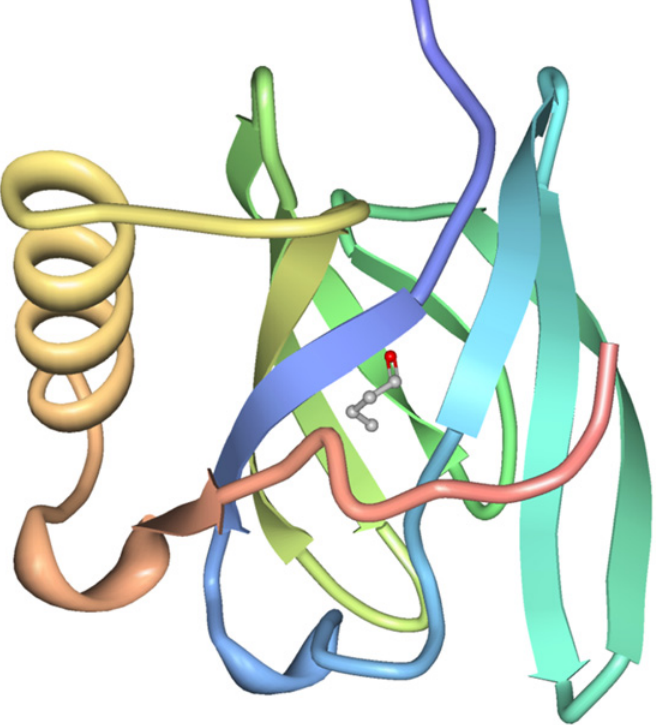
Fig 3. Porcine Odorant Binding Protein structure. Cartoon representation of the structure pOBP with butanal. The image was produced by Protein workshop Right.